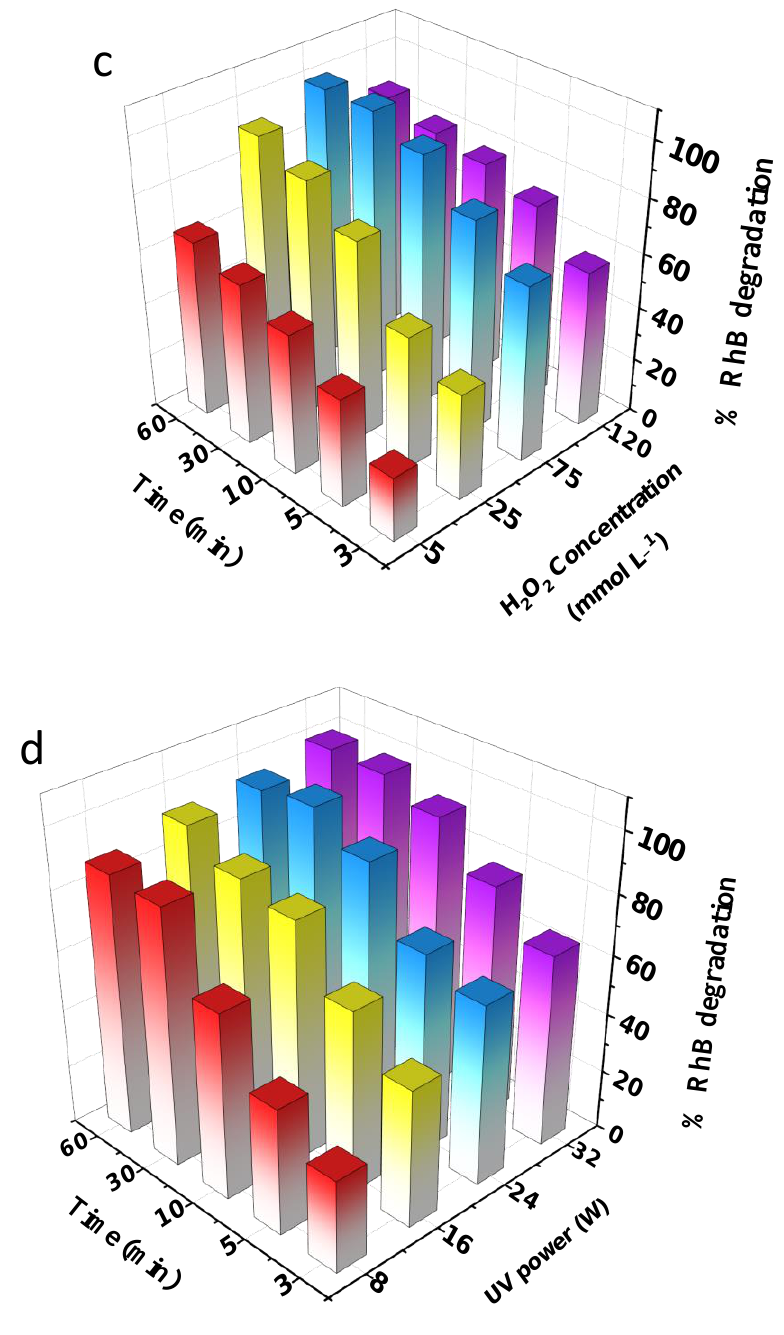
Figure 10. ( a ) Effect of catalyst dosage, ( b ) effect of initial concentration of RhB, ( c ) effect of H 2 O 2 concentration, ( d ) effect of UV power on photocatalytic Fenton-like degradation of RhB using Mn 1 Fe 5 @SiO 2